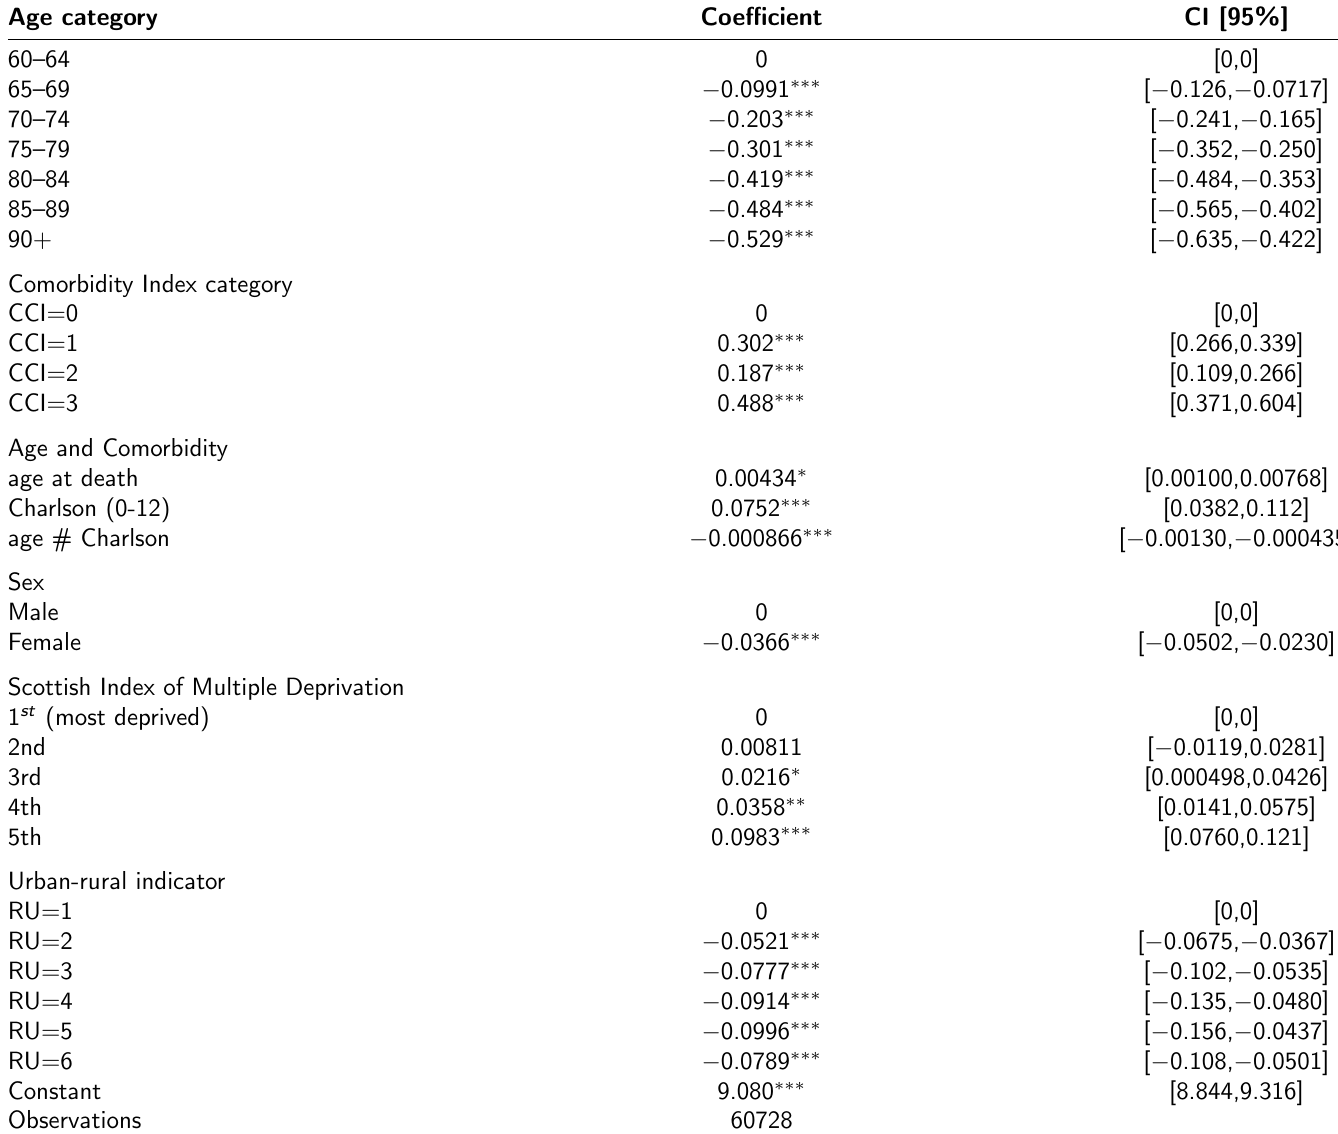
Supplementary Table 8: Multivariate analysis GLM - Cancer MAIN cause of